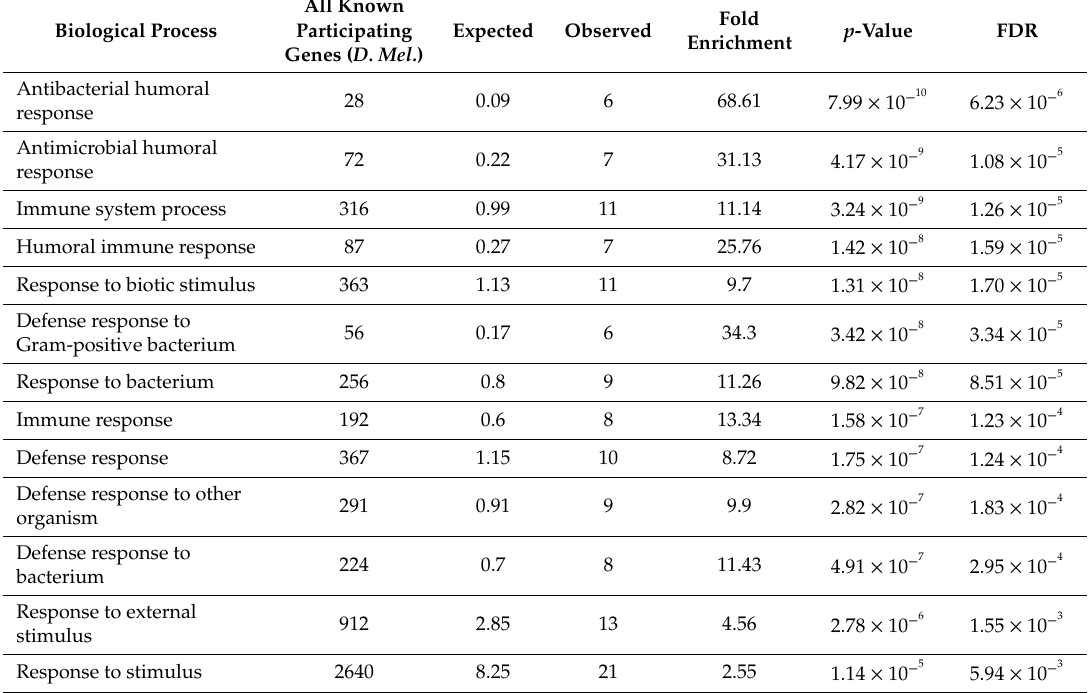
Table 3. Panther gene ontology analysis of fly heads. Gene ontology enrichment analysis of genes upregulated in heads of GBA1b m / m flies in comparison to age matched controls. Hyper genomic test was used for the calculation of fold